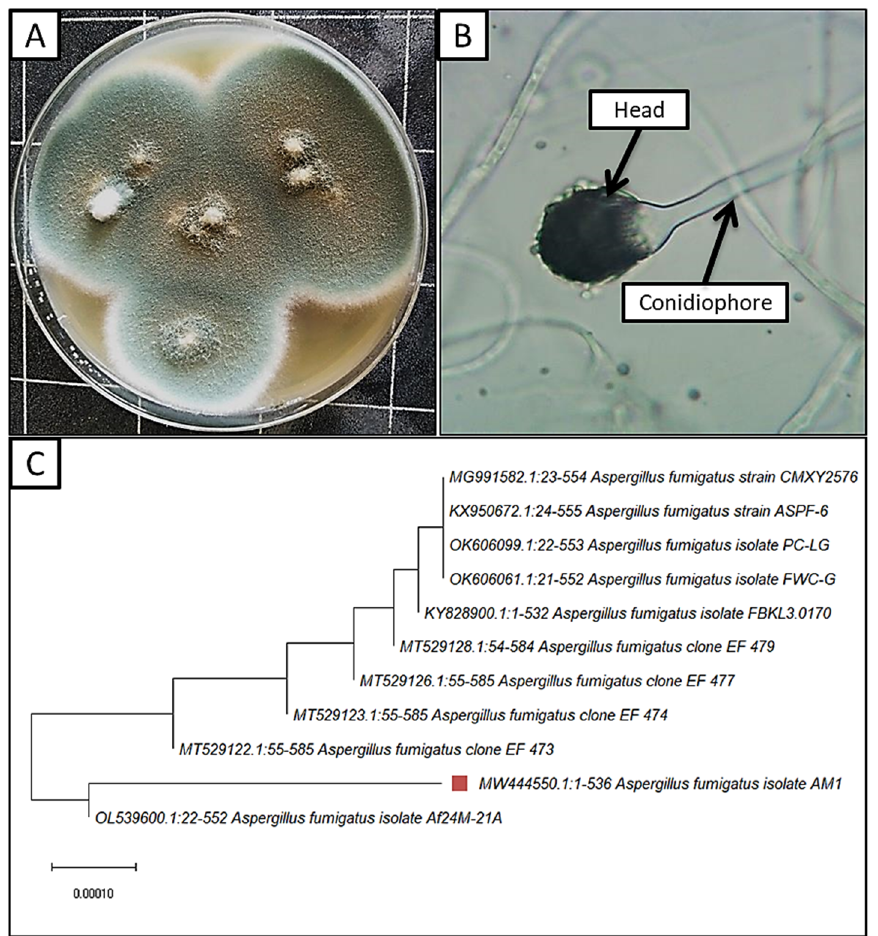
Figure 2. Morphological and molecular identification of A. fumigatus ( A – C ); ( A ) surface of culture on PDA; ( B ) conidiophores and head under the light microscope (400×); ( C ) Phylogenetic tree for A. on PDA; ( B ) conidiophores and head under the light microscope (400 × ); ( C ) Phylogenetic tree for fumigatus (brown square). A. fumigatus (brown